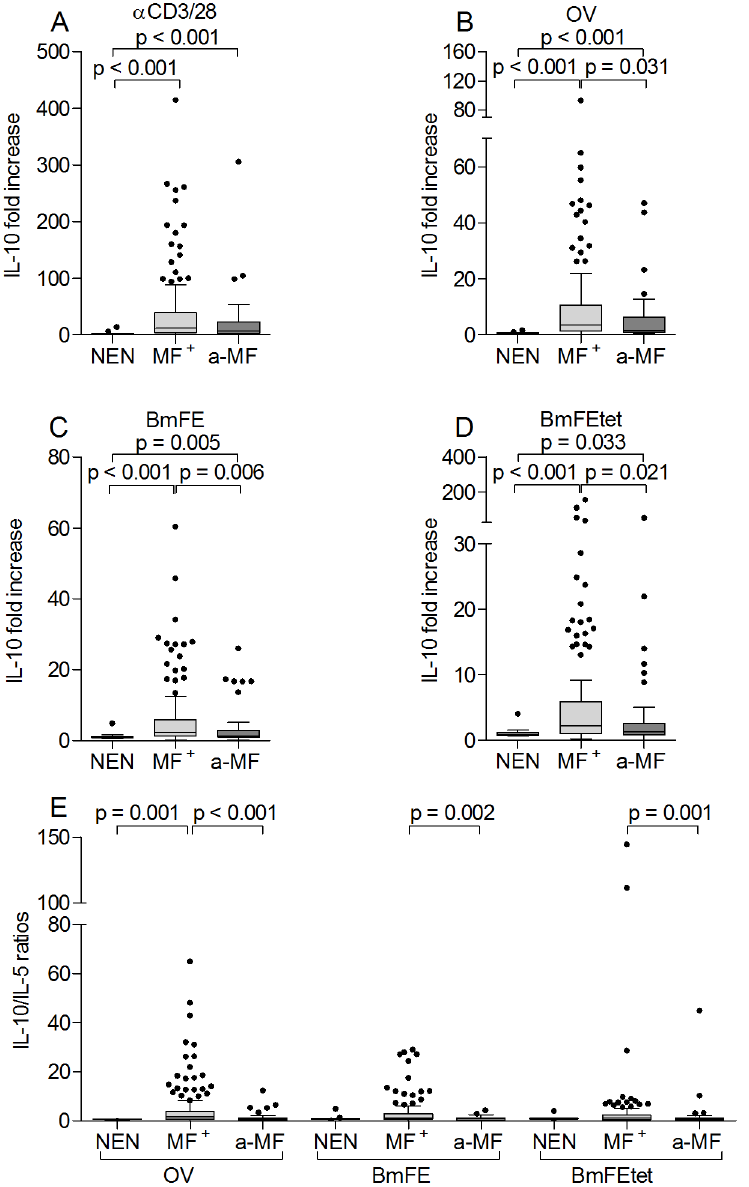
Figure 5. Elevated IL-10 levels in microfilaridermic patients. Isolated PBMCs (2 6 10 5 /well) from NEN or O. volvulus infected MF + or a-MF patients were stimulated with either anti-CD3/anti-CD28 (A), OV (B), BmFE extract (C) or BmFEtet extract (D) for 72 hours. Thereafter, levels of IL-10 were measured in the culture supernatants via ELISA. (E) shows the ratios of IL-10/IL-5 for each stimuli. Data are plotted as fold increase over unstimulated controls. Graphs show box whiskers with median, interquartile ranges and outliers. Statistical significances between the indicated groups were obtained after Kruskal-Wallis and Mann-Whitney tests.